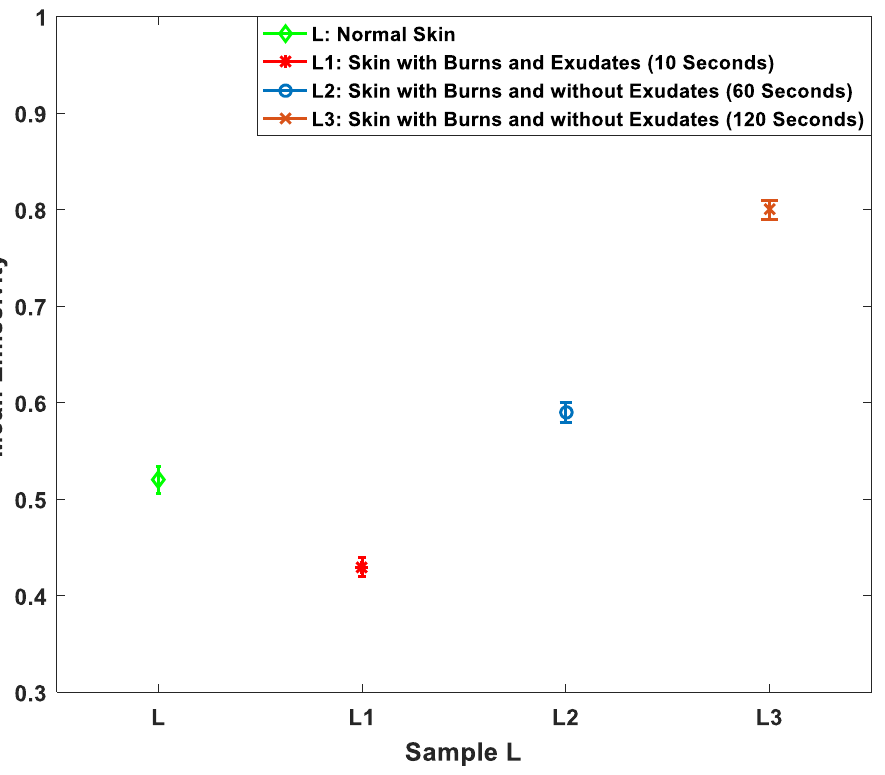
Figure 10. Mean emissivity values and standard deviation bars for porcine skin sample before and after different applications of localized heat treatments. L represents the normal skin; L1 represents skin with burns and exudates after 10 s of heat treatment, L2 represents skin with burns and without exudates after 60 s of extra heat treatment, L3 represents skin with burns and without exudates after 120 s of extra heat treatment.